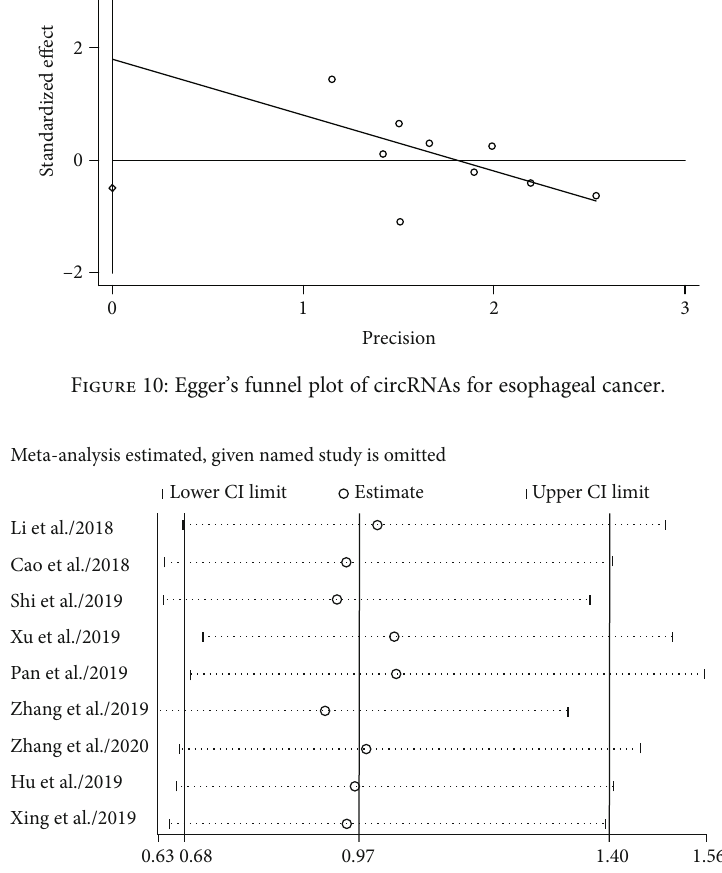
Figure 11: Sensitivity analysis of circRNAs for esophageal